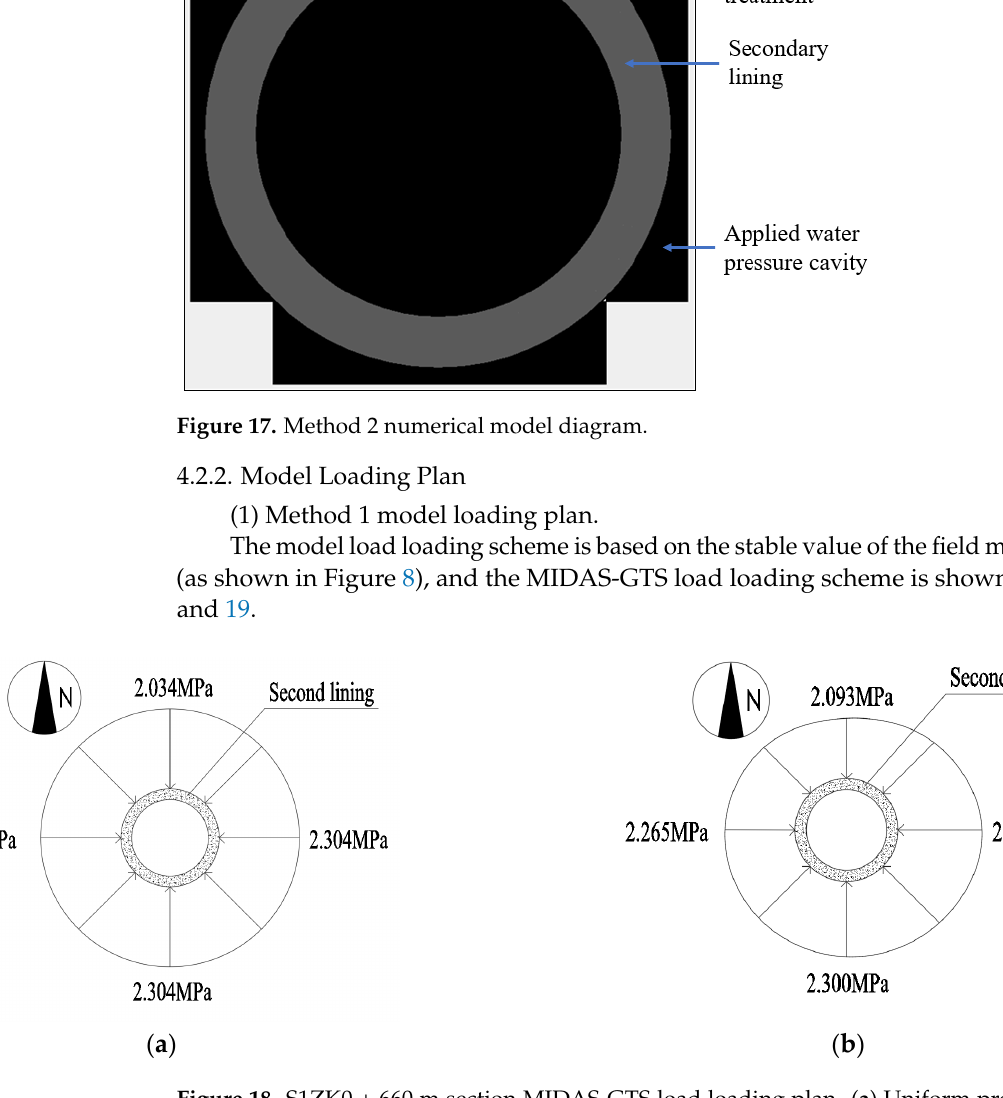
Figure 18. S1ZK0 + 660 m section MIDAS-GTS load loading plan. ( a ) Uniform pressure; ( b ) Non- uniform pressure.